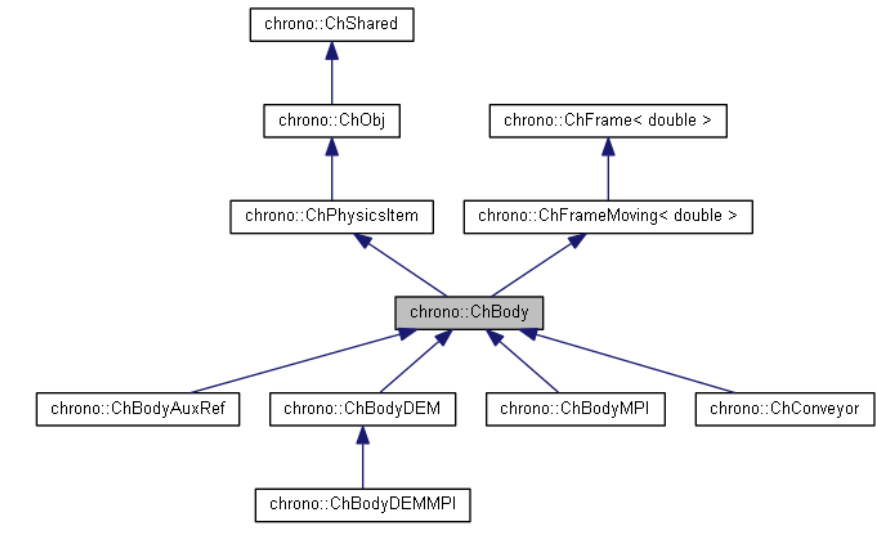
Figure 1. UML graph of dependencies between module libraries. Figure 1 : UML graph of dependencies between module libraries. Figure 2 : Class ineritance diagram for objects of ChBody type.